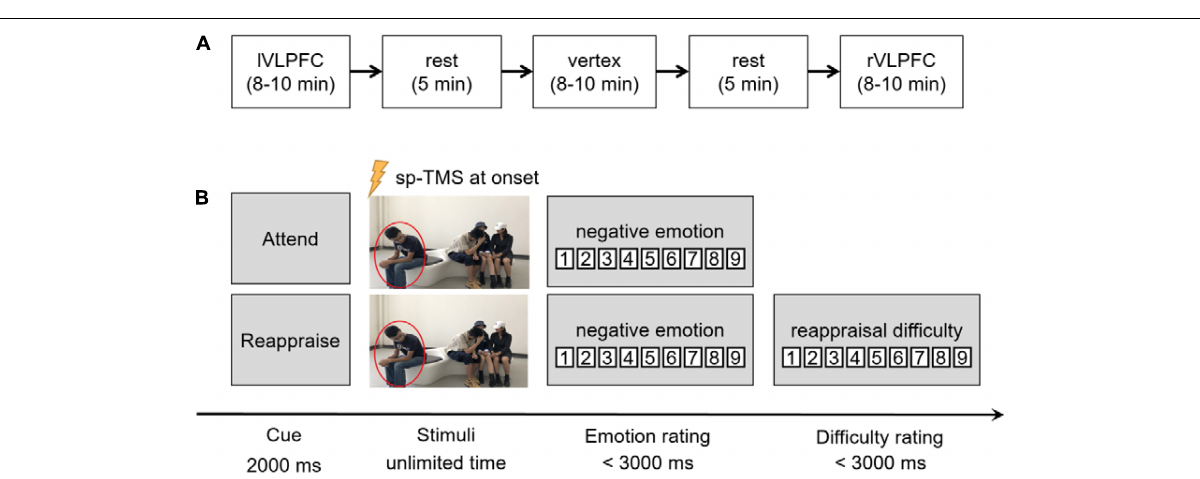
FIGURE 2 | Experimental procedures. (A) Illustration of the experimental procedure. The order of the three blocks were counterbalanced across individuals. Here, we show an order of “the left VLPFC block” that came the first, followed by “the vertex block,” and “the right VLPFC block” came last. (B) Illustration of one trial in the task. After the cue of “Attend” or “Reappraise,” a social exclusion picture was presented until the participant finished his/her oral report. Single-pulse TMS (spTMS) was delivered at the onset of picture presentation. Negative emotion rating was required in each trial, and the rating of reappraisal difficulty was also required in the reappraisal